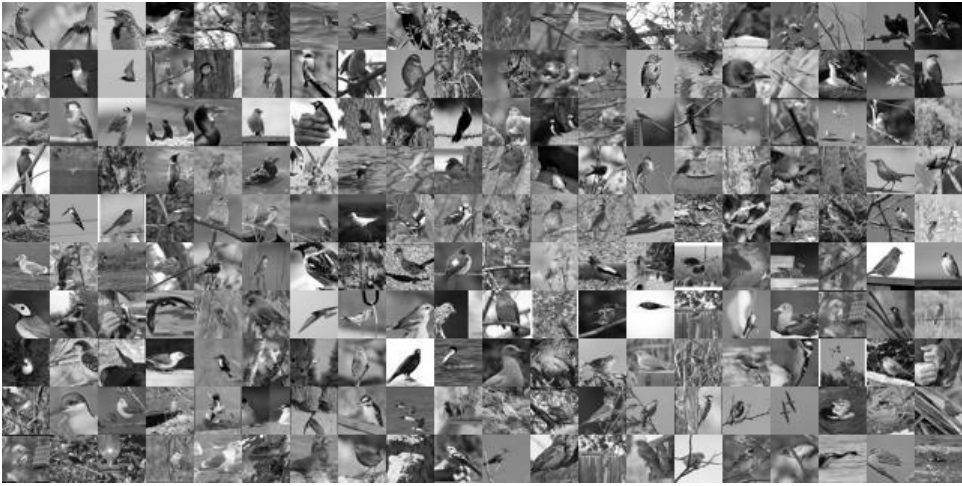
Figure 7. A sample of the CUB-200-2011 dataset